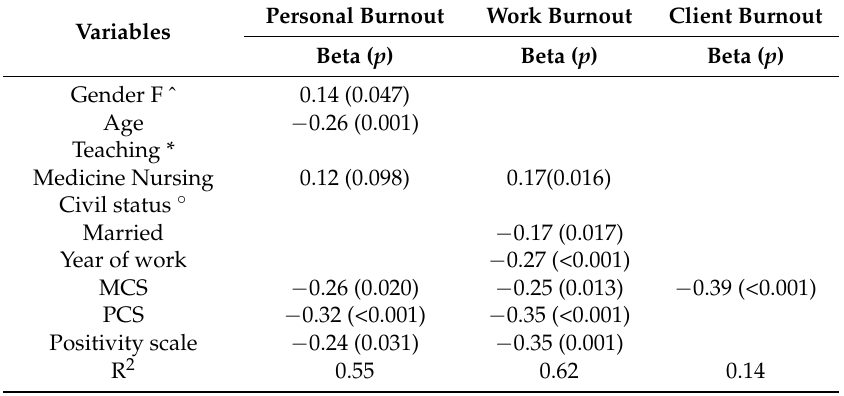
Table 5. Multivariate analyses for the three dimensions of the Copenhagen Burnout Inventory. Personal Burnout Work Burnout Client Burnout Variables Beta ( p ) Beta ( p ) Beta ( p ) Gender F ˆ 0.14 (0.047) Age − 0.26 (0.001) Teaching * Medicine Nursing 0.12 (0.098) 0.17(0.016) Civil status ◦ Married − 0.17 (0.017) Year of work − 0.27